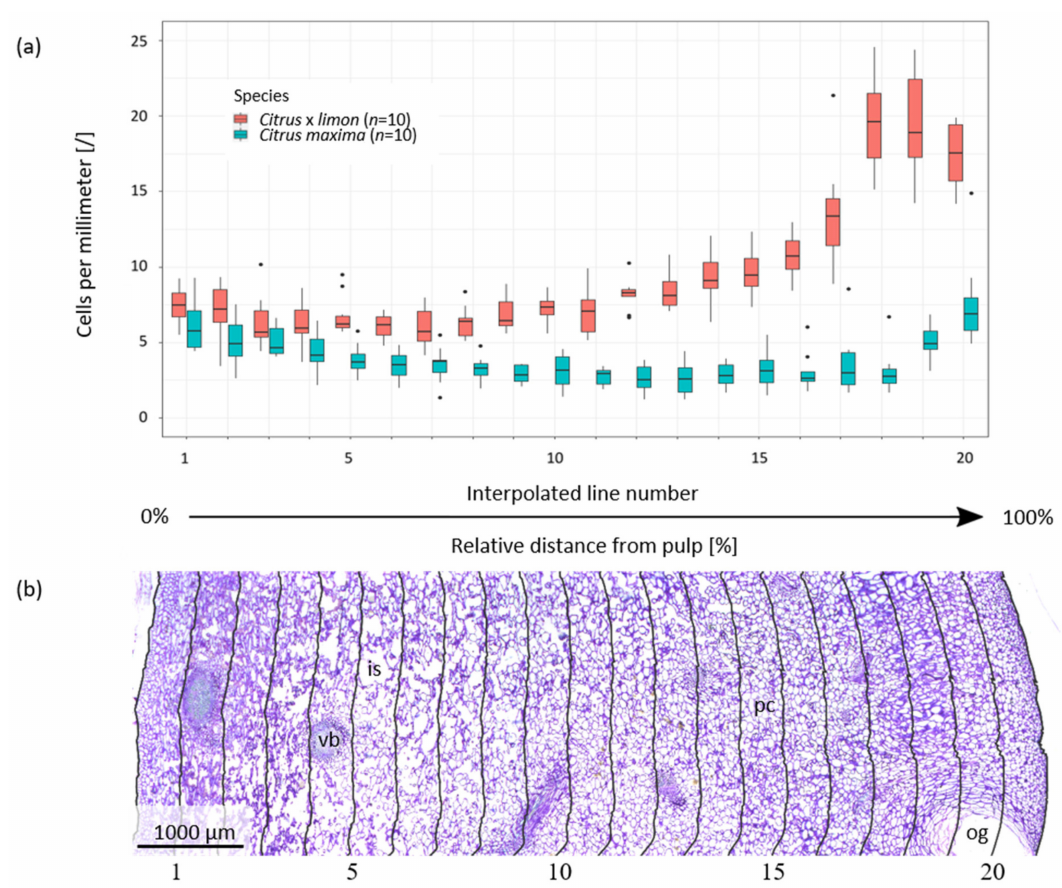
Figure 3. ( a ) Average cell number per millimeter counted at interpolated lines in thin sections of Citrus × limon and Citrus maxima . ( b ) Cross thin section of the peel Citrus × limon stained with toluidine blue, showing the 20 interpolated lines along which the cell numbers have been counted. The cross thin section of Citrus × limon is characteristic for both species from a qualitative point of view. The peel of both species mainly consists of oil glands (og), parenchyma (pc), intercellular spaces (is) and vascular bundles (vb). The cell density shows a gradual decrease from the outside of the peel (right) to the inside. In the flavedo close to the epidermis (right) the cells are visibly more densely arranged than in the part of the albedo which is close to the endocarp (left).